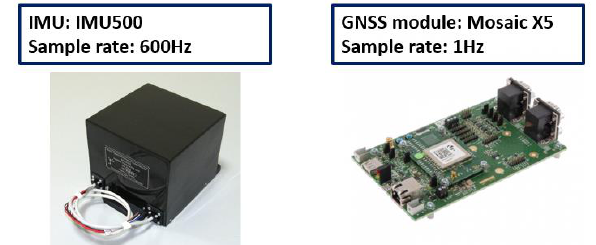
Figure 1 .IMU500 and Septentrio Mosaic-X5 in the integrated navigation system